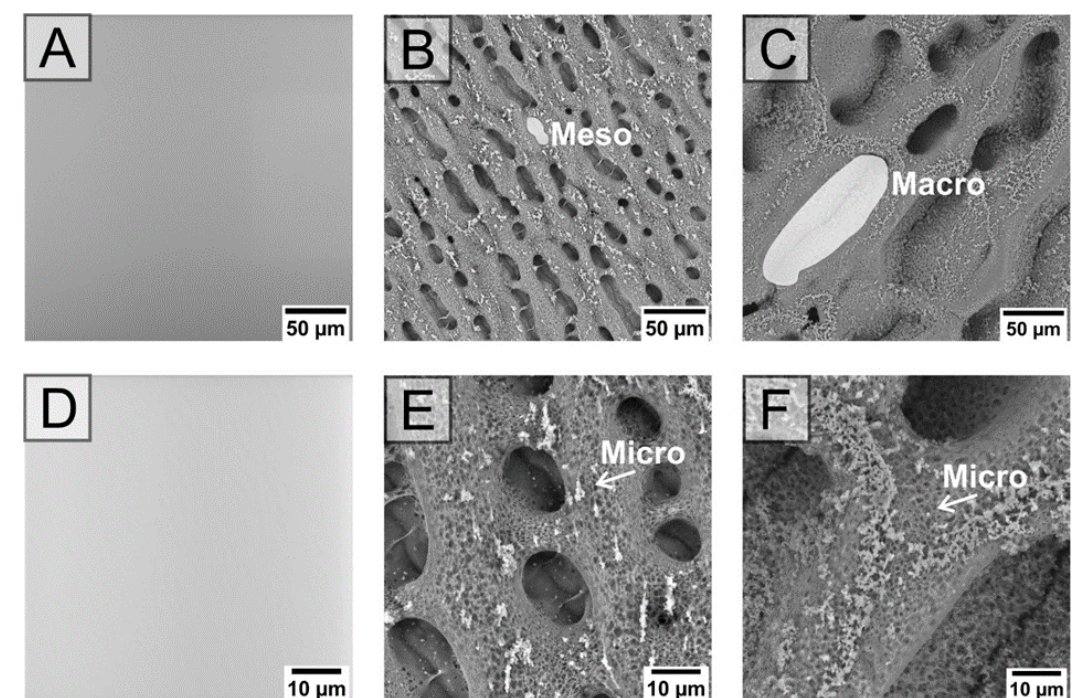
Figure 1. SEM images of native ( A , D ), meso-structured ( B , E ), and macro-structured ( C , F ) substrates. Differences in the sizes of pores are clearly visible from figures ( A – C ). Both the hierarchically structured meso- and macro-structured substrates demonstrate similar micro pores.